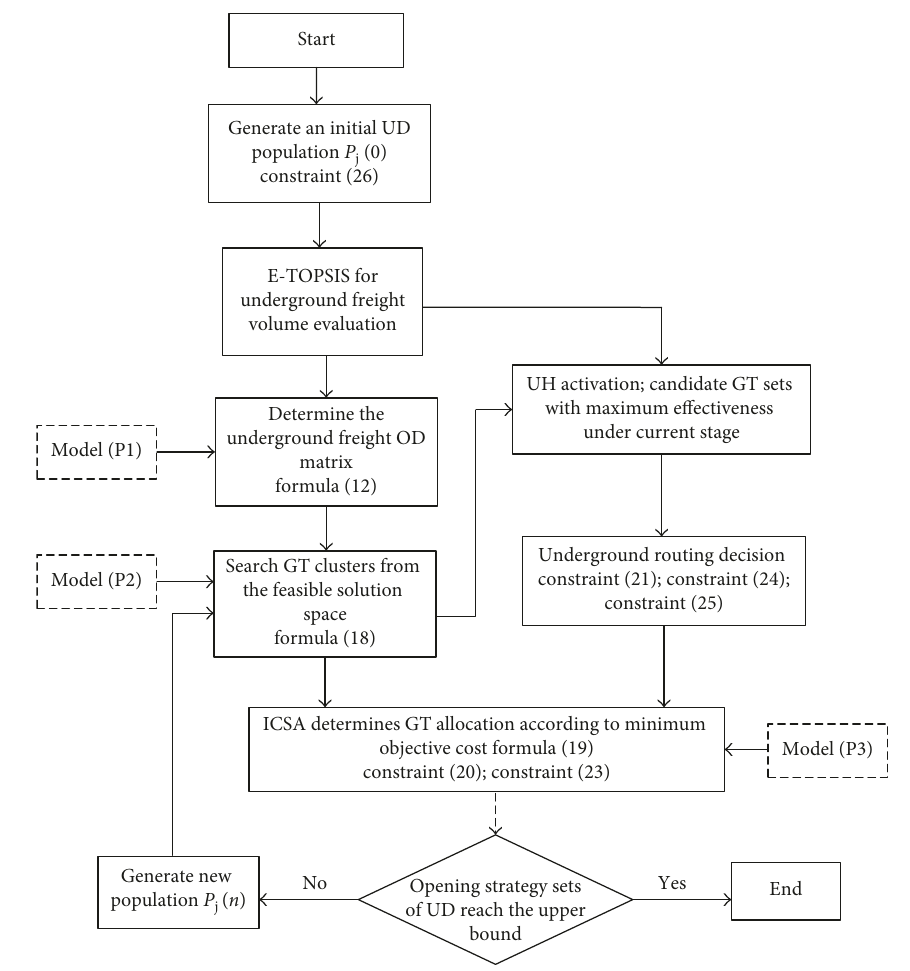
Figure 2: Relationships and decomposition of proposed models.